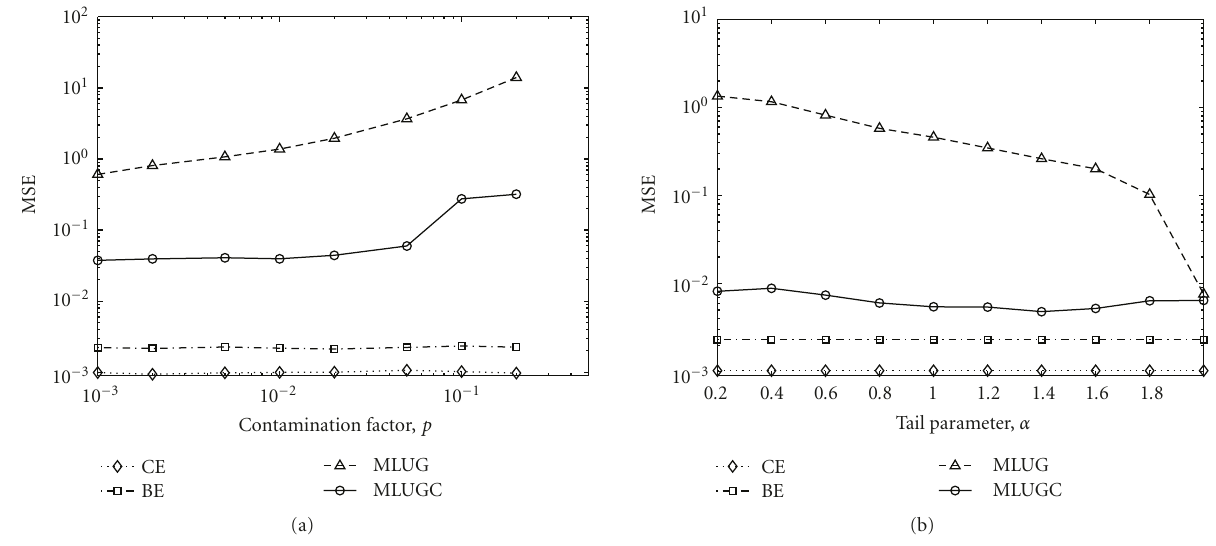
Figure 7: Sensor network example with parameters: θ = 1, τ = 0, σ n = 1, and K = 1000. Comparison of MLUGC, MLUG, BE, and CE. (a) = 0 . 5. MSE as function of the of the contamination parameter, p . (b) Channel Channel noise contaminated p -Gaussian distributed with σ 2 w noise α -stable distributed with σ w = 0 . 5. MSE as function of the tail parameter, α .